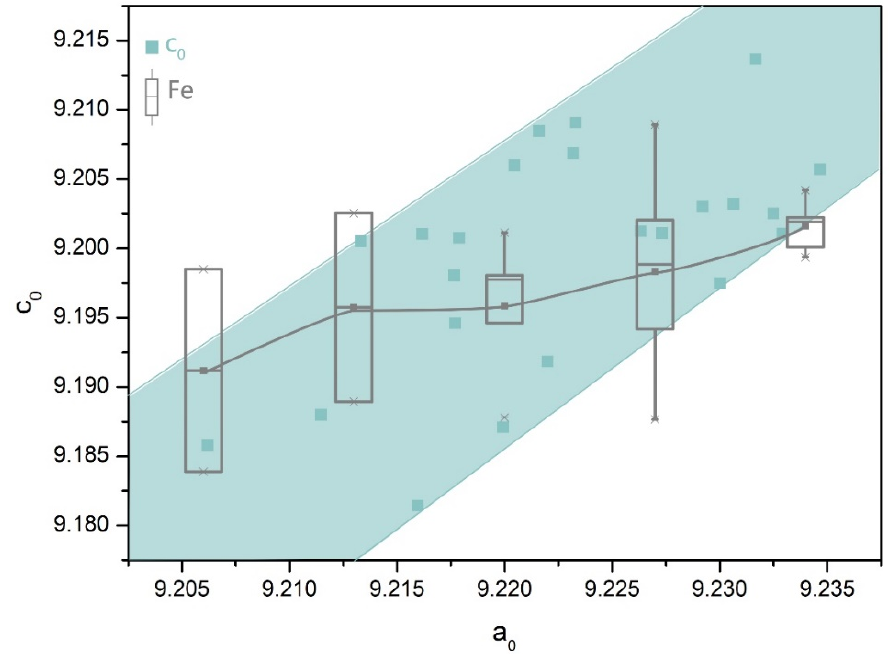
Figure 4. Diagram of a 0 , c 0 , and the total Fe in direct proportion. Blue dots are c 0 , which show a positive relationship with a 0 ; Fe contents were divided into different groups by K-means clustering and every grey box is the Fe content within a group.